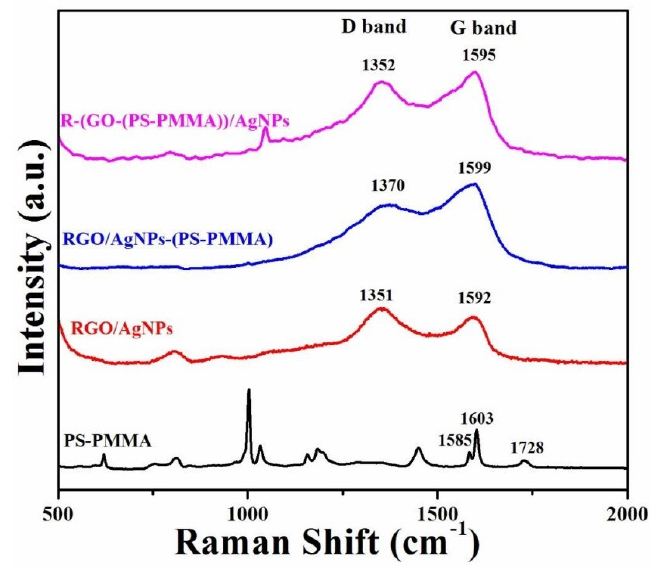
Figure 4. Raman spectra of PS-PMMA, RGO/AgNPs, RGO/AgNPs-(PS-PMMA), and R-(GO-(PS-PMMA)-AgNPs.